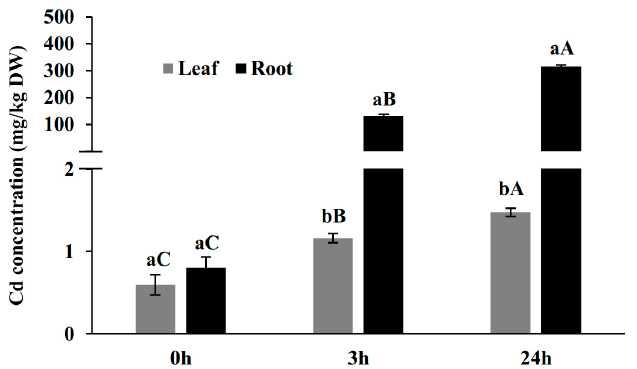
Figure 1. Cadmium (Cd) concentrations in root (black bars) and shoot (gray bars) at T0, T3 and T24. Different small letters indicate significant differences at p < 0.05 level of LSD test between two organs at the same time point. Different capital letters indicate significant differences at p < 0.05 level among different time points in the same tissue.